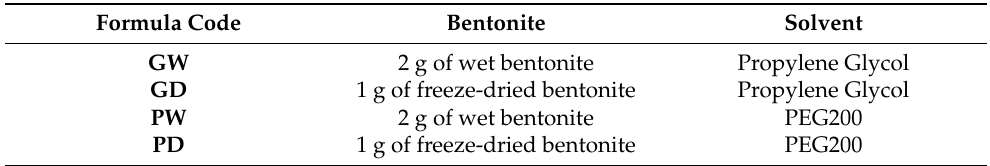
Table 1. Formula code of the prepared extracts from freeze dried and wet waste bentonite by Propylene Glycol (G) and PEG200